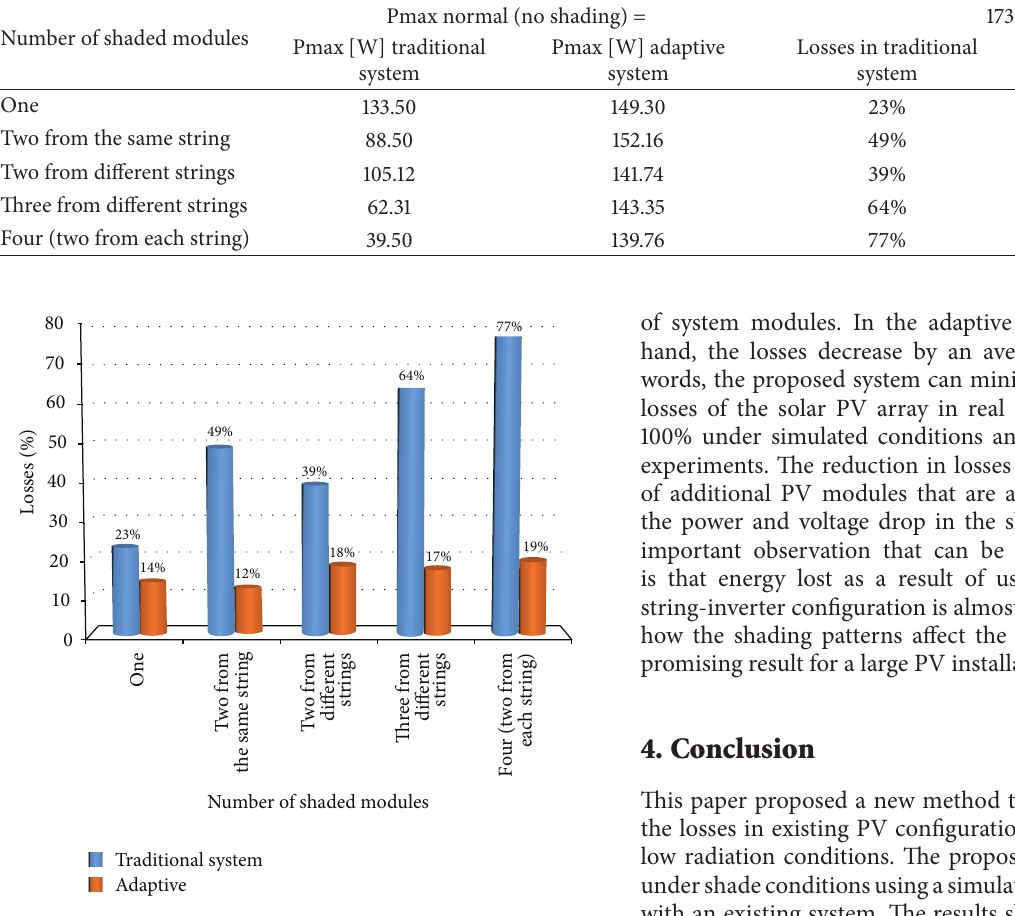
Figure 9: Comparison of losses between traditional and proposed adaptive